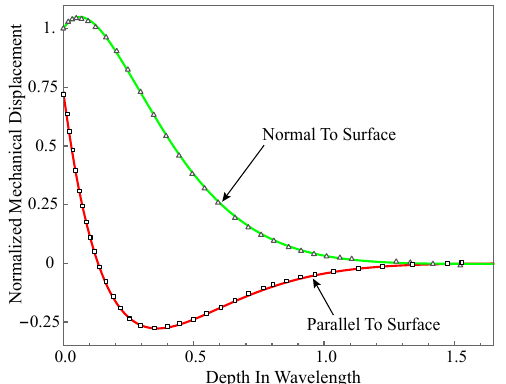
Figure 2. Normalized mechanical displacement amplitude distribution: solid curves are our results, and dotted lines are from literature.